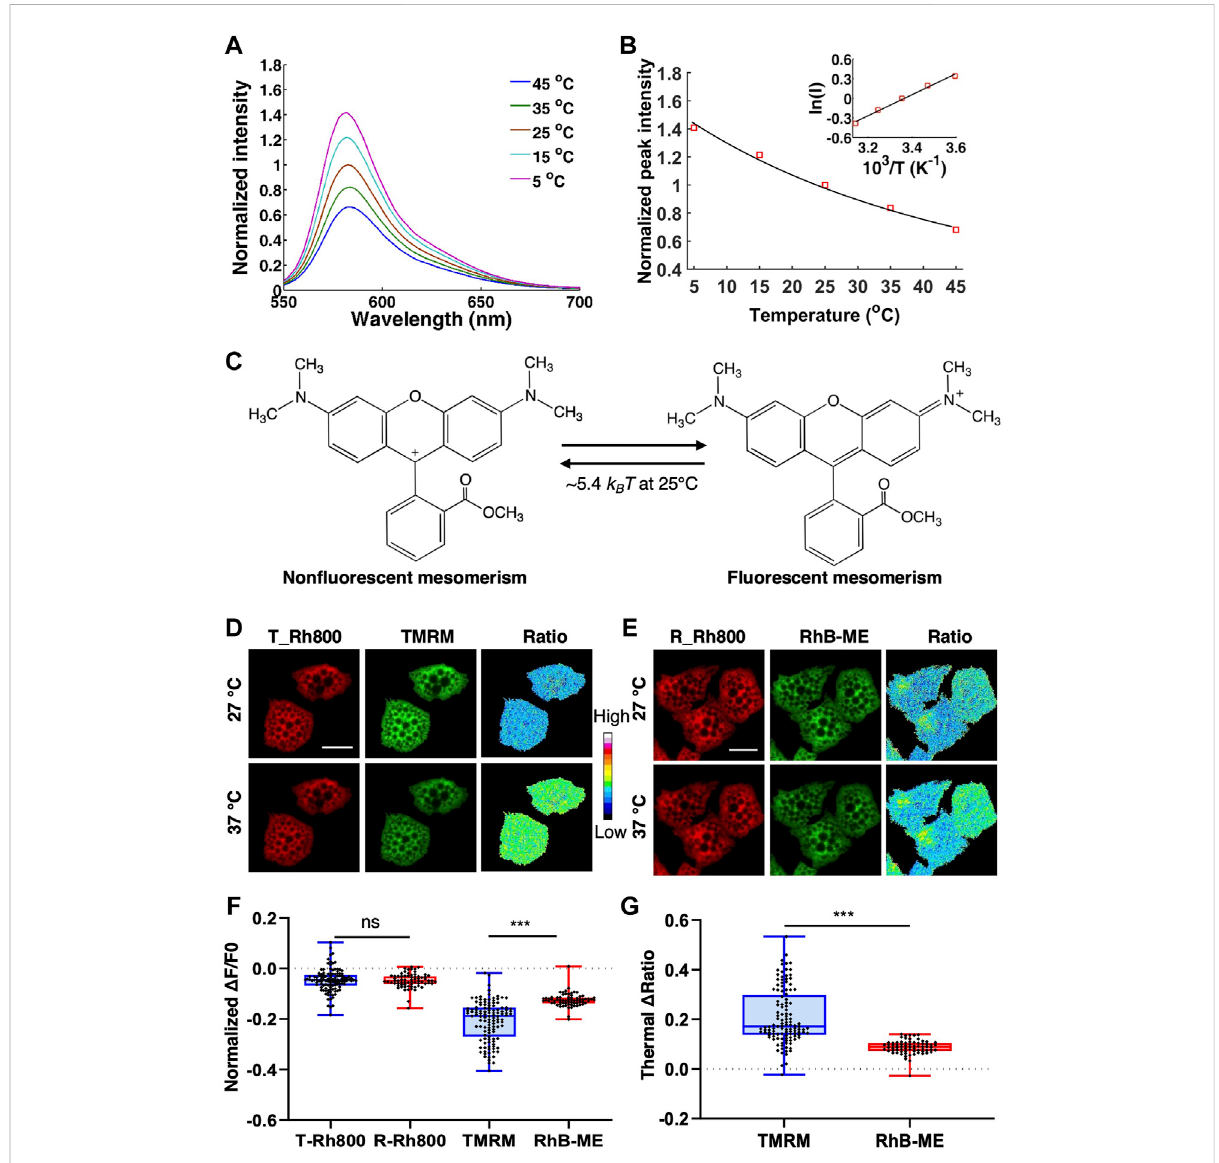
FIGURE 2 The thermochromic mechanism and temperature sensitivity of TMRM. (A) , the emission spectra of 10 μ M TMRM (solid lines) from 5 to 45 ° C, respectively. (B) , the Arrhenius plot for TMRM thermochromic transformation in aqueous solution. The black solid line indicates the Arrhenius fi tting tothepeakvalues(redsquare)ofTMRMdatainpanelA.TheinsetshowstheArrheniusplot. (C) ,thethermalenergy(~5.4kBTat25 ° C)convertssingle TMRM fl uorescentmoleculetoitsnon fl uorescentform.D-G,brownadipocyteswereco-stainedwith50 nMofRh800and50 nMofTMRM (D) , or 50 nM of Rh800 and 50 nM of RhB-ME (E) , and then incubated at 27 ° C or 37 ° C. (D,E) , the representative fl uorescence images and thermal ratio images of brown adipocytes at 27 ° C or 37 ° C. The pseudo-color ratio of Rh800 to TMRM (D) or Rh800 to RhB-ME (E) represented thermal status. Scalebars,20 μ m. (F) ,thescatter plotwithboxplotsshowed thechangesin fl uorescentintensity ofRH800,TMRMandRhB-MEfrom27to37 ° C.The results showed that the fl uorescent intensity of Rh800 co-stained with TMRM (T_Rh800, n = 120) and co-stained with RhB-ME (R_Rh800, n = 71) changedslightlyafterincreasingtemperature.The fl uorescenceintensityofTMRM(n=120)droppedsigni fi cantlymorethanthatofRhB-ME(n=71). (G) , the scatter plot with boxplots showed the thermal ratio of Rh800 to TMRM (n = 120) was signi fi cantly larger than the ratio of Rh800 to RhB-ME (n = 71). Box and whiskers. Min to Max. Each point represented a single